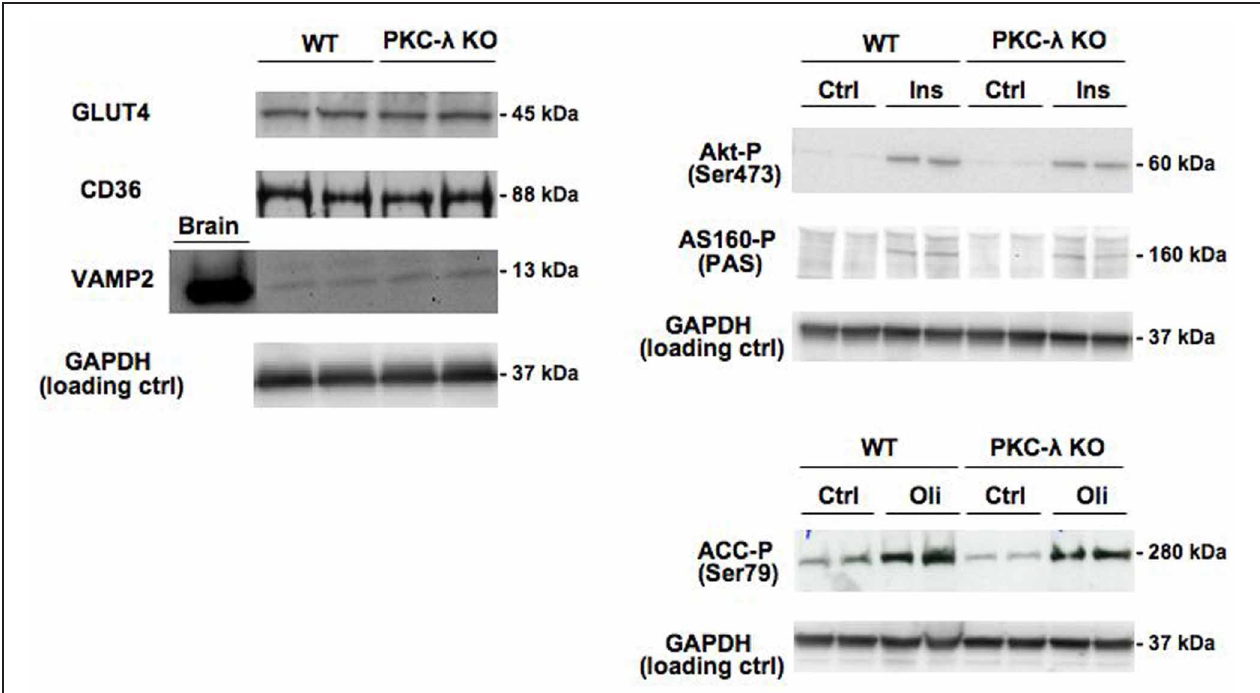
of 100nM insulin (Ins) or 1 μ M oligomycin (Oli) for assessment of phospho-Akt (Ser473), phospho-ACC (Ser79), and phospho-AS160 by Western blotting. In case of VAMP2, a sample from homogenized rat brain of identical protein content was used as a positive control on the expression of this protein. A representative Western blot is presented out of five experiments with different cardiomyocyte